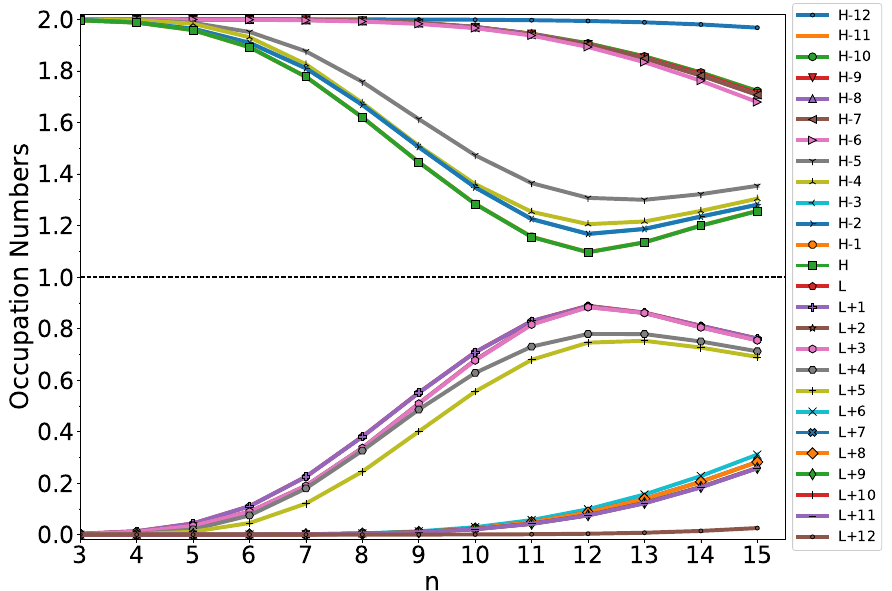
Figure 5. Active TAO-orbital occupation numbers (H − 12 , H − 11, ..., H − 1, H, L, L + 1, ..., L + 11, and L + 12) of ground-state n -HGQR, calculated by spin-restricted